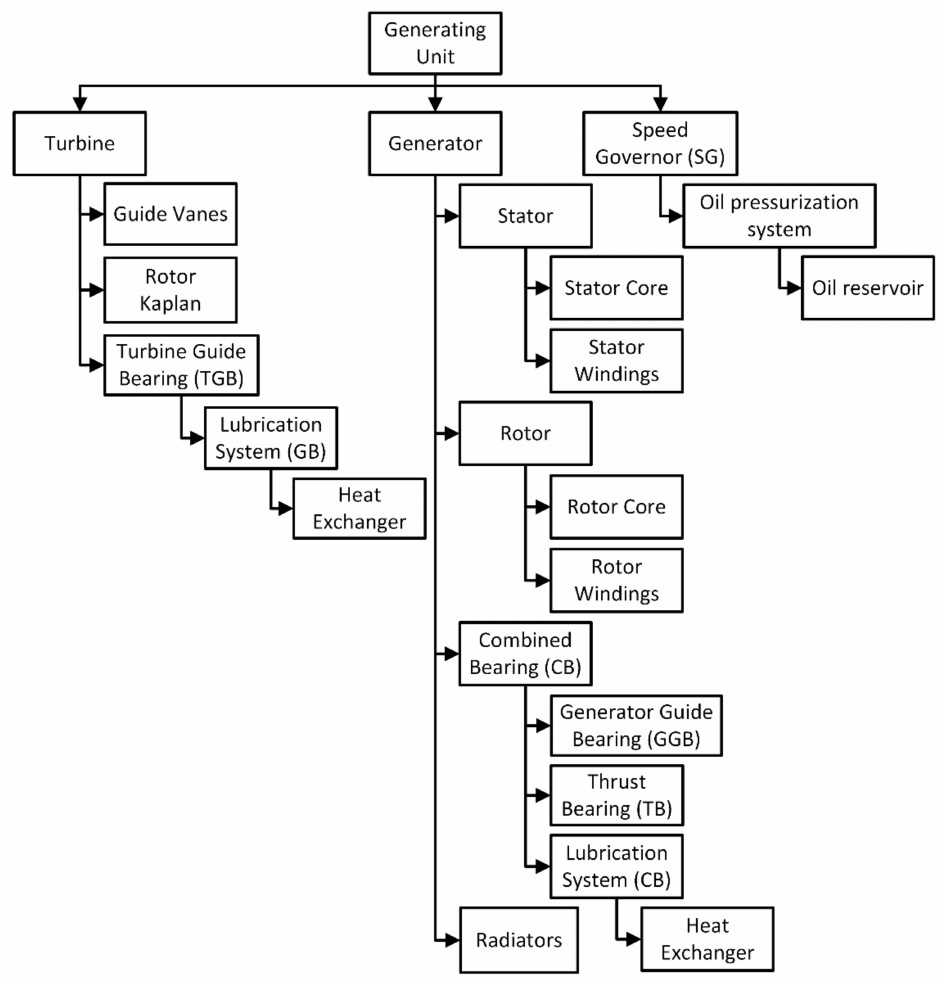
Figure 5. Functional tree. Table 2. Failure modes and clusters